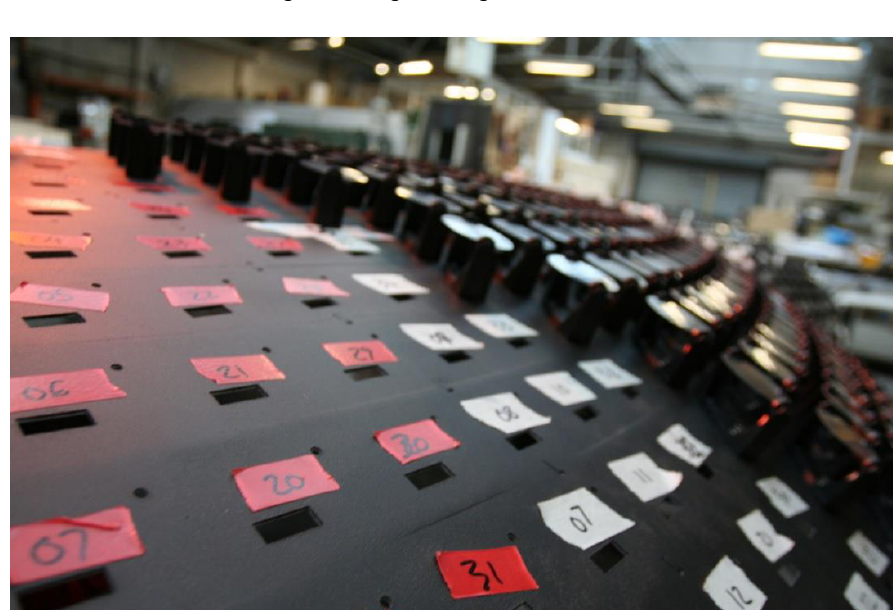
Figure 3. Programming of "The Cloud"